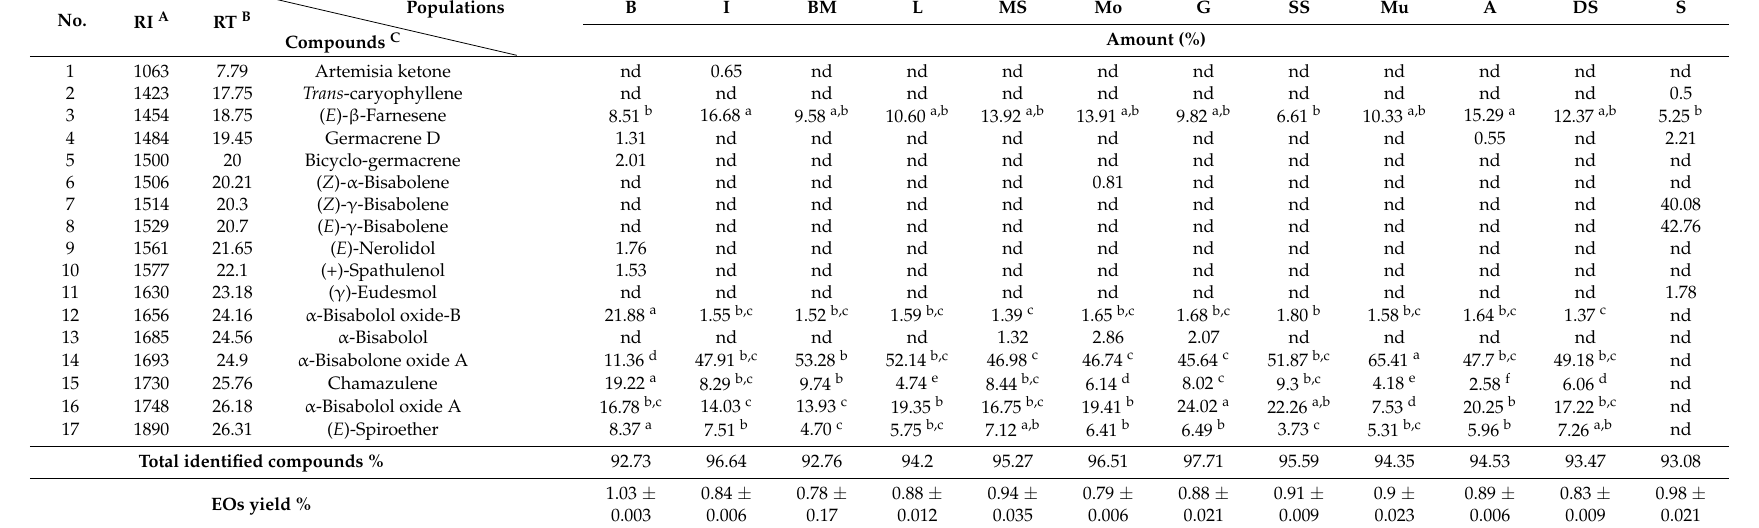
Table 1. Essential oil constituents and yields of twelve harvested Matricaria chamomilla